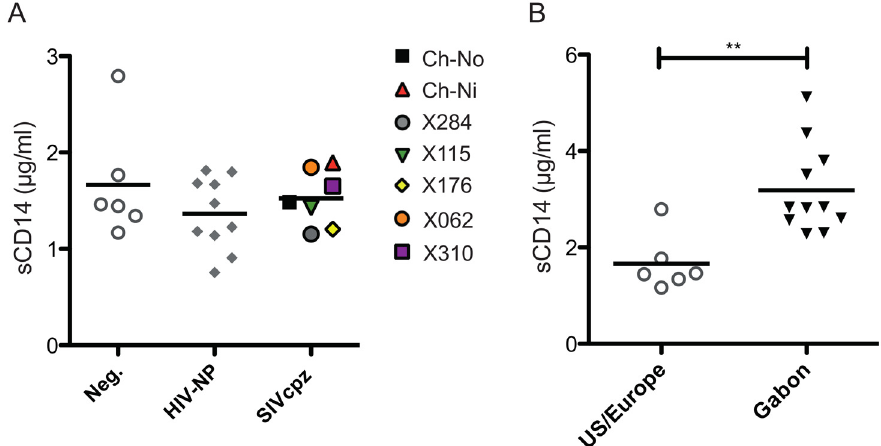
Fig 8. Levels of plasma soluble CD14 in uninfected and SIVcpz infected chimpanzees. (A) Levels of plasma sCD14 were determined in uninfected and chronic HIV-1 and SIVcpz infected chimpanzees. (B) Levels of sCD14 in uninfected chimpanzees held in two primate centres in the US and Europe, compared with chimpanzees housed at the CIRMF, Gabon. Horizontal black bars indicate the mean value in each group. ** indicates a P-value of < 0.01 in a Mann-Whitney U test, two